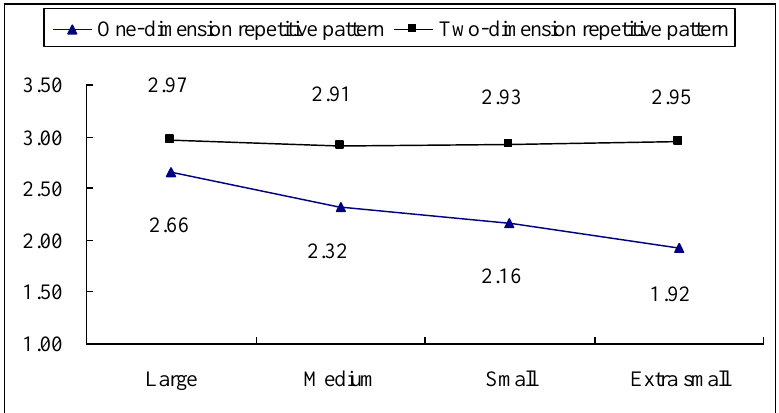
Figure 6. Interaction between floral pattern sizes and pattern types.